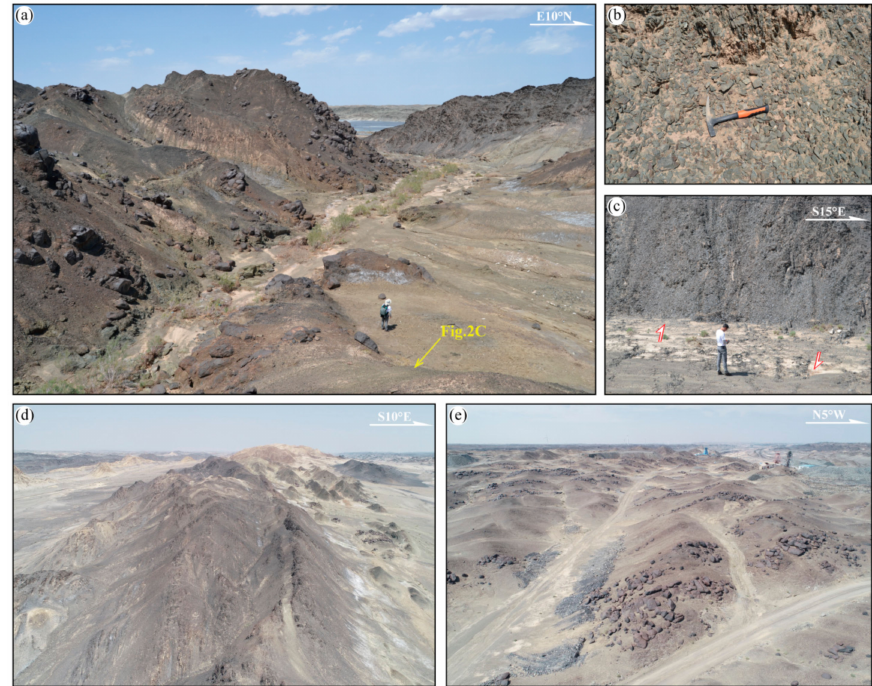
Figure 2. Field photographs showing surface rocks and faults in Huangshan mineragenetic region. Partial outcrops ( a ) and strong surface’s weathering ( b ) in the middle of HSX-I intrusion. The dextral strike-slip shearing fault in the eastern of HSX-I intrusion ( c ). Partial outcrops of HSX-II intrusion ( d ) and of Hangshandong (HSD) intrusion ( e ). Photo locations are showing in Figure